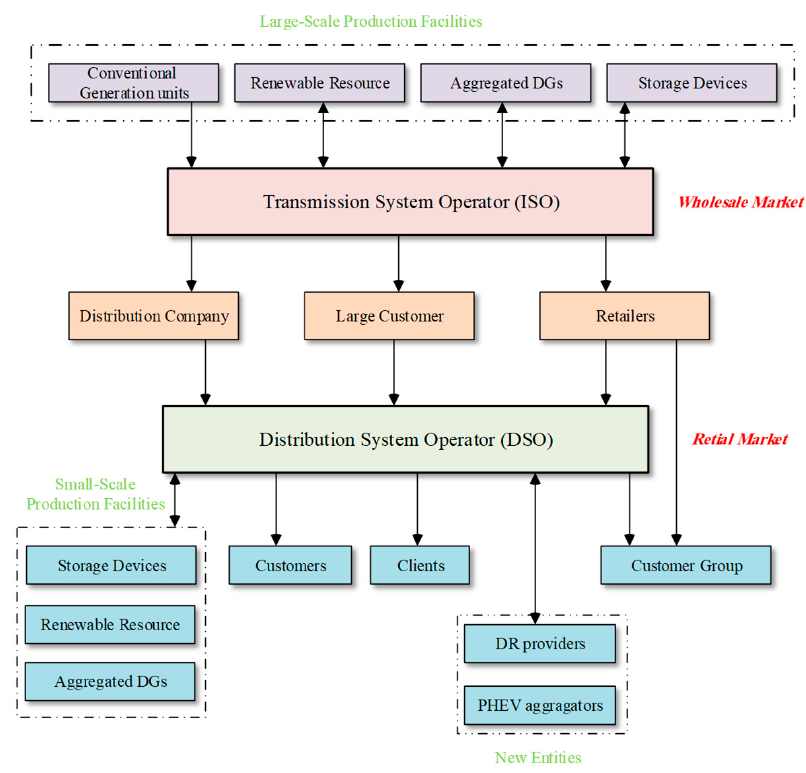
Figure 1. Overview of the wholesale and retail market in the power system.